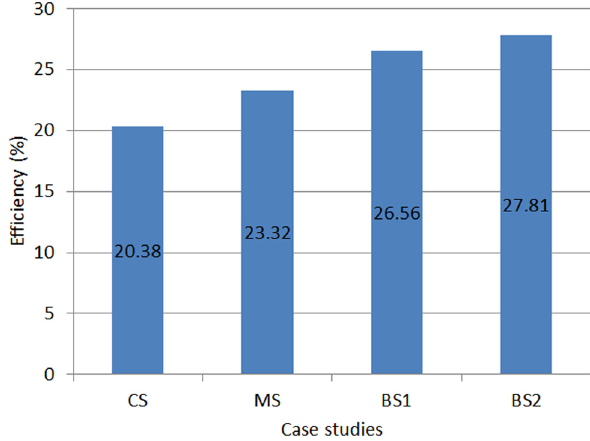
Table 5: Expected fresh water productivity from the solar stills